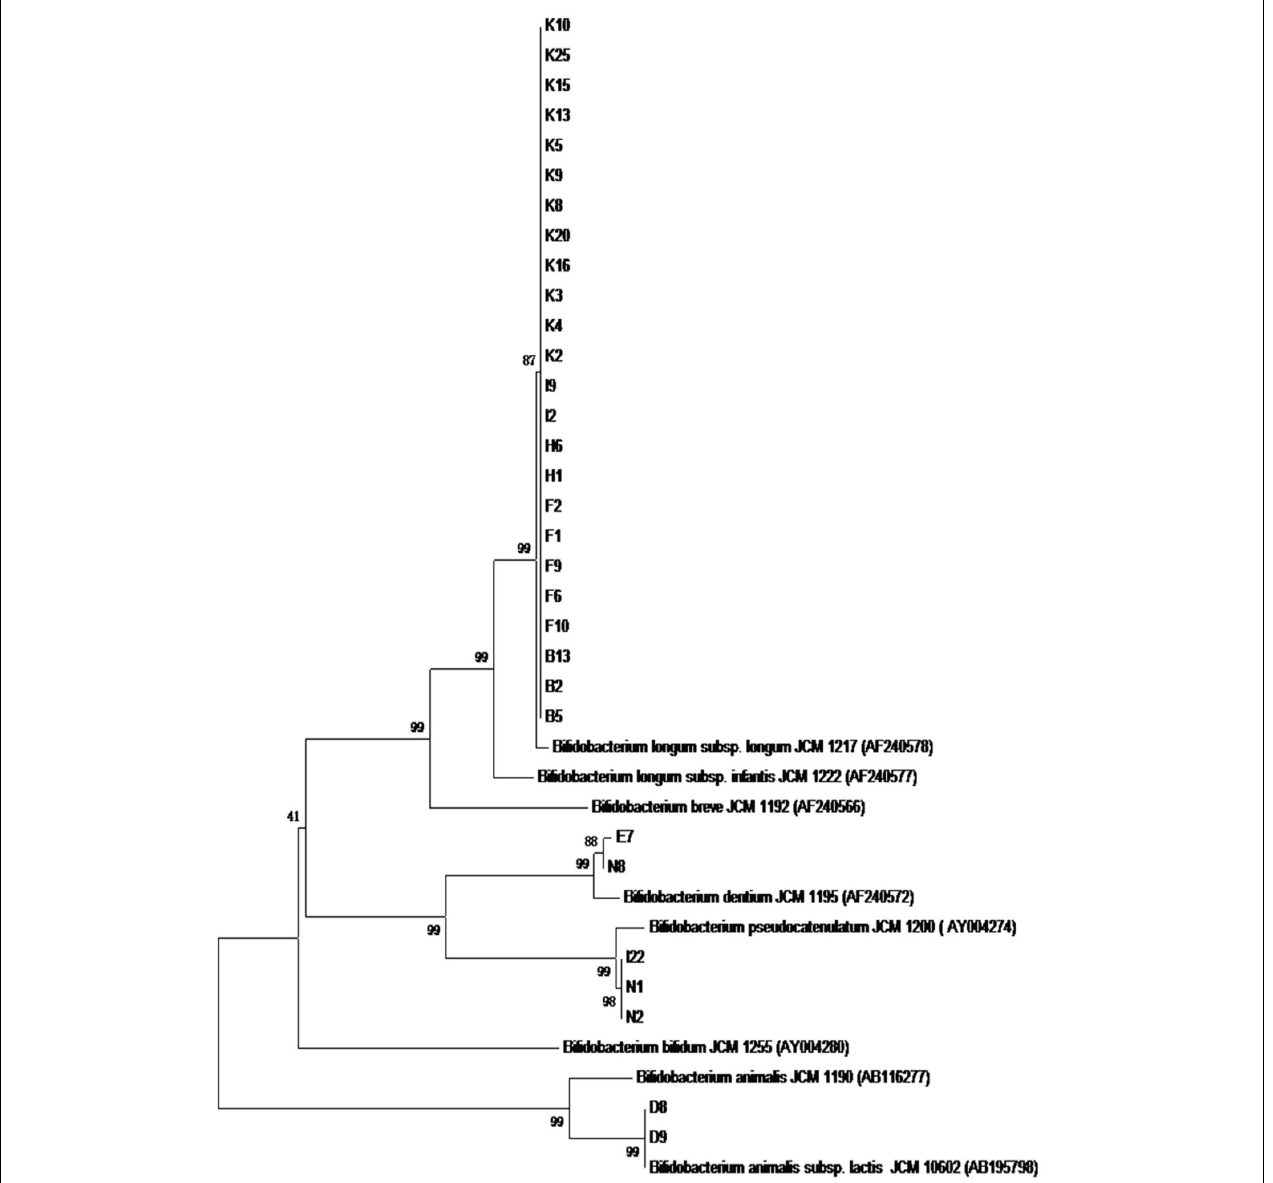
FIGURE 3 | The phylogenetic tree based on the sequences of the PCR production of hsp60 gene for 31 Bifidobacterium strains.